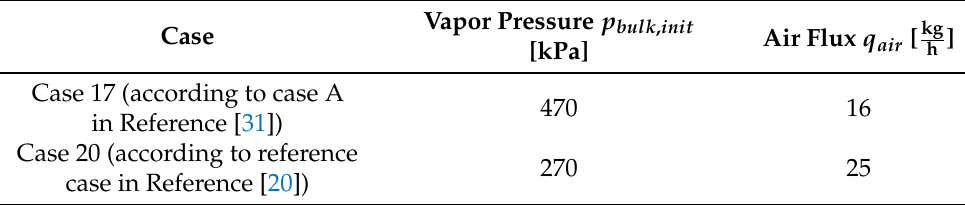
Table 3. Experimental setups, as basis for the